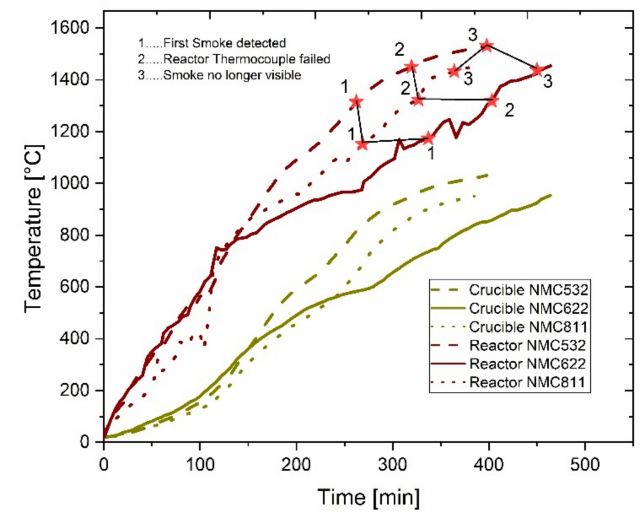
Figure 3. Curves of the temperature inside the reactor and at the outer wall of the crucible during carbo-thermal reduction experiments of NMC532, NMC622, and NMC811.